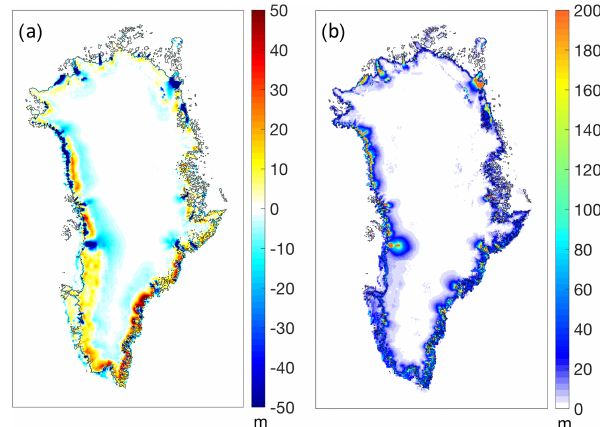
Figure 11. Dynamic contribution for experiment MIROC5-RCP8.5. (a) Ensemble mean dynamic ice thickness change residual and (b) standard deviation. See Fig. S9 in the Supplement for patterns for each individual